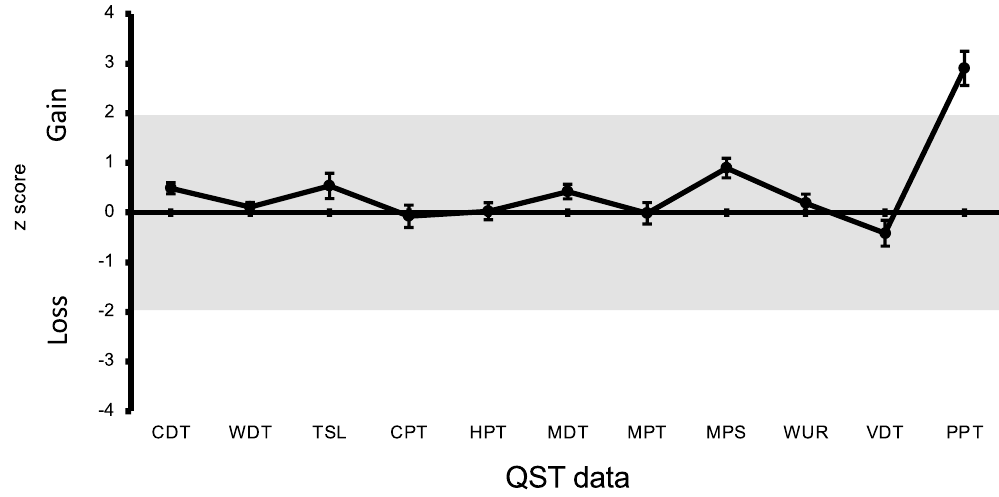
Figure 2. Z-scores on the Masseter for the MPP group. Error bars indicate the standard deviation of the mean. CDT = cold detection threshold ; WDT = warm detection threshold ; TSL = thermal sensory limen ; CPT = cold pain threshold ; HPT = heat pain threshold ; MPT = mechanical pain threshold ; MPS = mechanical pain sensitivity ; DMA = dynamic mechanical allodynia ; WUR = wind-up ratio; MDT = mechanical detection threshold ; PPT = pressure pain threshold .The gray zone (z score between − 1.96 and 1.96) represents the 95% confidence interval of baseline values.